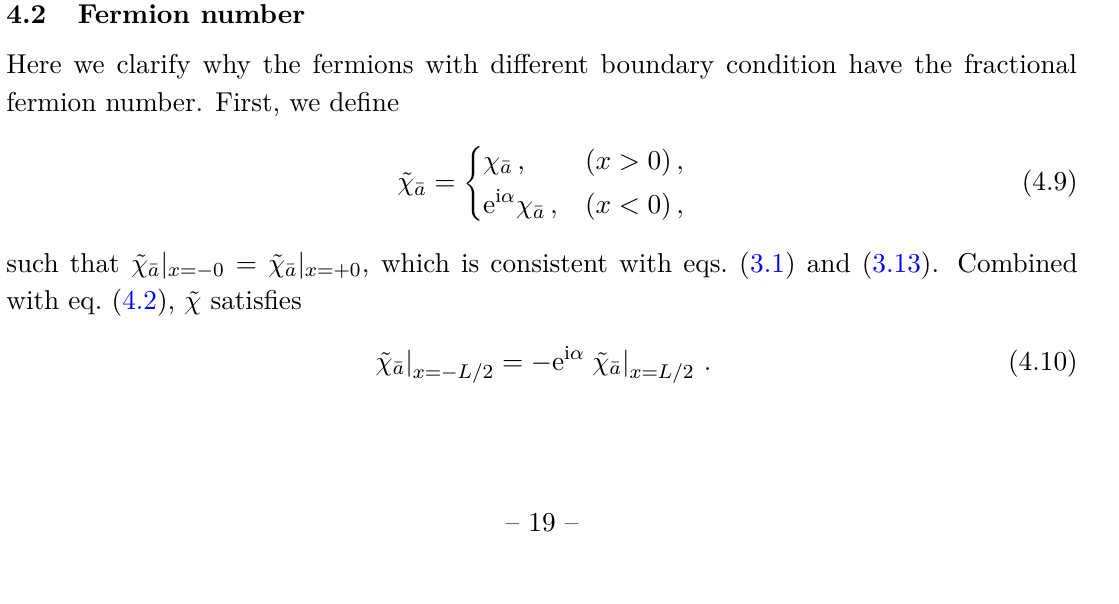
Figure 2 . The fermion spectrum before and after the scattering for N = 4 . Left: initial state; = 1 , n in = 0 . Right: a candidate of the final state; n out n in 1 2 , 3 , 4 Fock vacuum after the scattering has ± 1 / 2 fermion number as the vacuum contribution. This is interpreted as the semiton